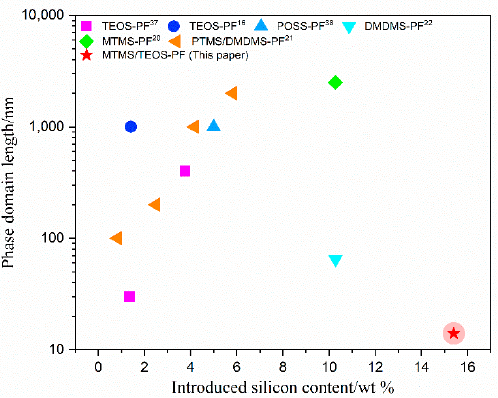
Figure 1. Phase domain length and introduced silicon content of reported silicon modified phenolic resins, with the relevant references shown at the upper right of each item.